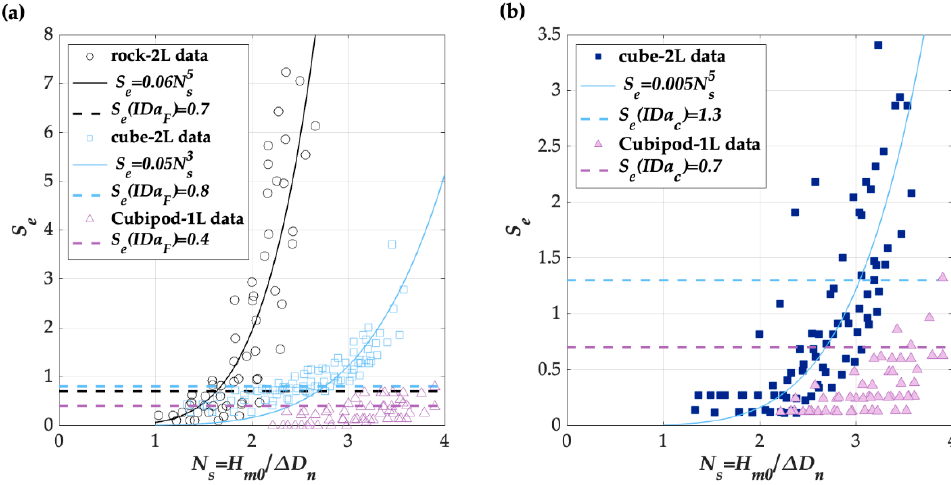
Figure 13. Comparison of the damage curves of the three armor units: ( a ) front slope, and ( b ) crest.